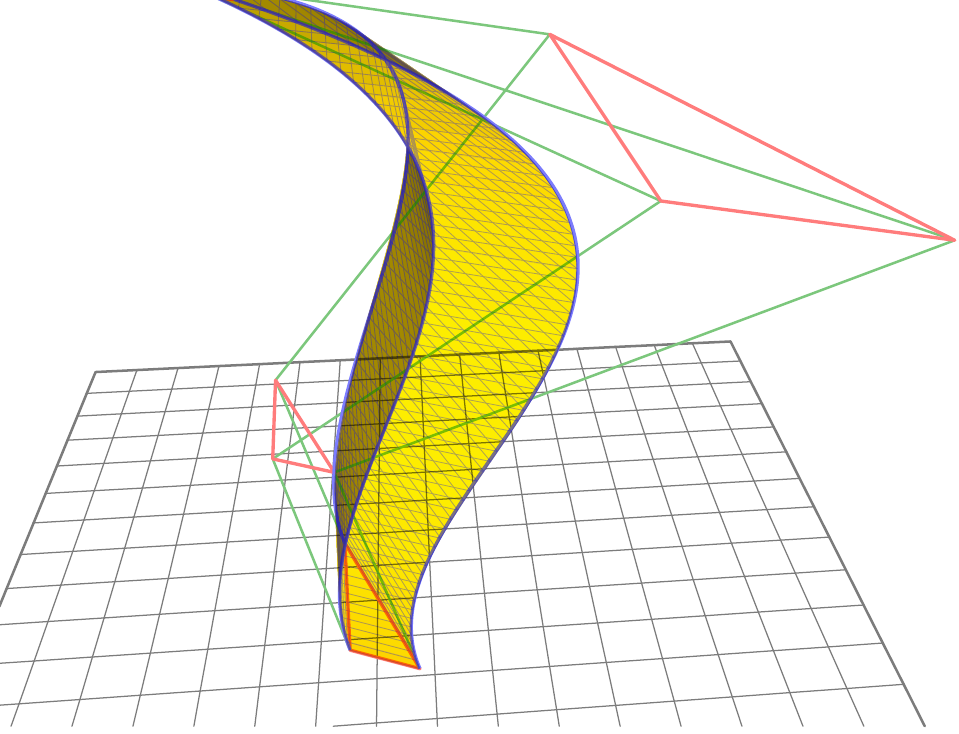
Figure 14. Developed surfaces created using method two, note that the ends of each panel are